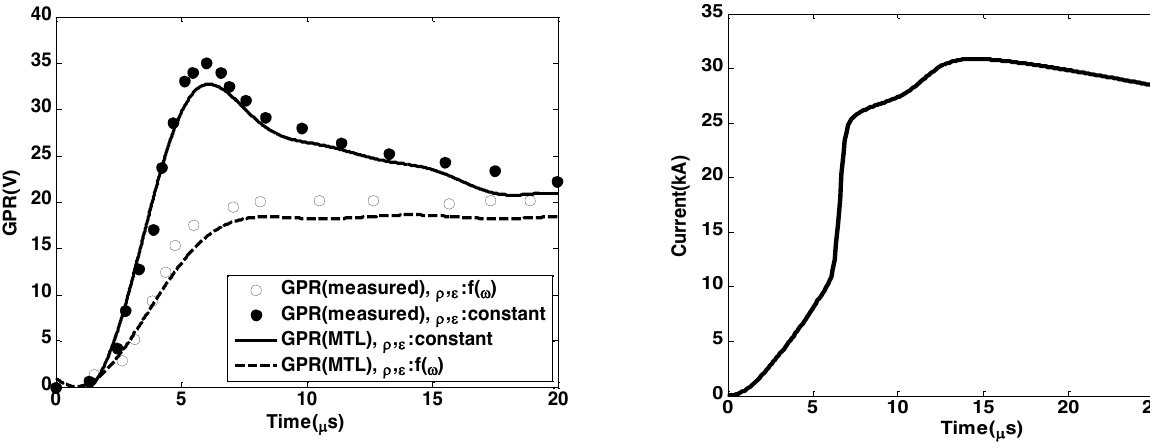
Figure 10: GPRs of grounding grid using MTL and comparision with measurement [10].